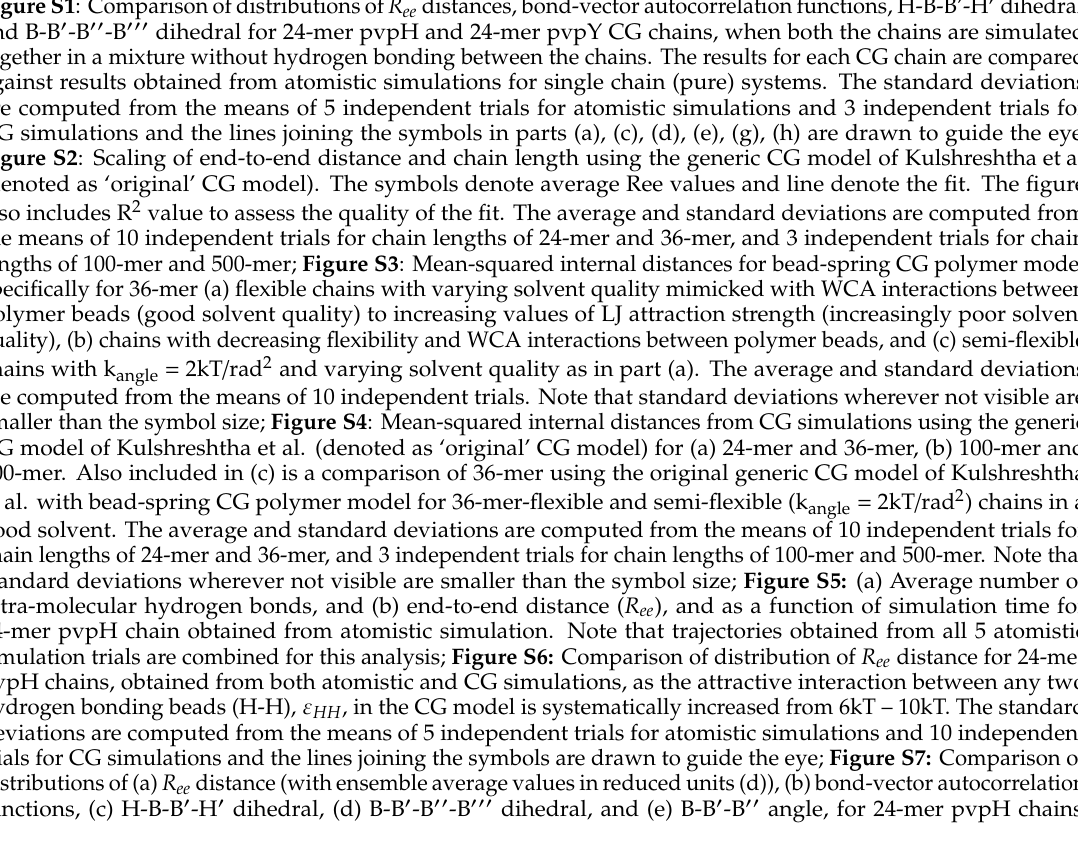
Figure S1 : Comparison of distributions of R ee distances, bond-vector autocorrelation functions, H-B-B’-H (cid:48) dihedral, and B-B (cid:48) -B (cid:48)(cid:48) -B (cid:48)(cid:48)(cid:48) dihedral for 24-mer pvpH and 24-mer pvpY CG chains, when both the chains are simulated together in a mixture without hydrogen bonding between the chains. The results for each CG chain are compared against results obtained from atomistic simulations for single chain (pure) systems. The standard deviations are computed from the means of 5 independent trials for atomistic simulations and 3 independent trials for CG simulations and the lines joining the symbols in parts (a), (c), (d), (e), (g), (h) are drawn to guide the eye; Figure S2 : Scaling of end-to-end distance and chain length using the generic CG model of Kulshreshtha et al. (denoted as ‘original’ CG model). The symbols denote average Ree values and line denote the fit. The figure also includes R 2 value to assess the quality of the fit. The average and standard deviations are computed from the means of 10 independent trials for chain lengths of 24-mer and 36-mer, and 3 independent trials for chain lengths of 100-mer and 500-mer; Figure S3 : Mean-squared internal distances for bead-spring CG polymer model specifically for 36-mer (a) flexible chains with varying solvent quality mimicked with WCA interactions between polymer beads (good solvent quality) to increasing values of LJ attraction strength (increasingly poor solvent quality), (b) chains with decreasing flexibility and WCA interactions between polymer beads, and (c) semi-flexible chains with k angle = 2kT / rad 2 and varying solvent quality as in part (a). The average and standard deviations are computed from the means of 10 independent trials. Note that standard deviations wherever not visible are smaller than the symbol size; Figure S4 : Mean-squared internal distances from CG simulations using the generic CG model of Kulshreshtha et al. (denoted as ‘original’ CG model) for (a) 24-mer and 36-mer, (b) 100-mer and 500-mer. Also included in (c) is a comparison of 36-mer using the original generic CG model of Kulshreshtha et al. with bead-spring CG polymer model for 36-mer-flexible and semi-flexible (k angle = 2kT / rad 2 ) chains in a good solvent. The average and standard deviations are computed from the means of 10 independent trials for chain lengths of 24-mer and 36-mer, and 3 independent trials for chain lengths of 100-mer and 500-mer. Note that standard deviations wherever not visible are smaller than the symbol size; Figure S5: (a) Average number of intra-molecular hydrogen bonds, and (b) end-to-end distance ( R ee ), and as a function of simulation time for 24-mer pvpH chain obtained from atomistic simulation. Note that trajectories obtained from all 5 atomistic simulation trials are combined for this analysis; Figure S6: Comparison of distribution of R ee distance for 24-mer pvpH chains, obtained from both atomistic and CG simulations, as the attractive interaction between any two hydrogen bonding beads (H-H), ε HH , in the CG model is systematically increased from 6kT – 10kT. The standard deviations are computed from the means of 5 independent trials for atomistic simulations and 10 independent trials for CG simulations and the lines joining the symbols are drawn to guide the eye; Figure S7: Comparison of distributions of (a) R ee distance (with ensemble average values in reduced units (d)), (b) bond-vector autocorrelation functions, (c) H-B-B (cid:48) -H (cid:48) dihedral, (d) B-B (cid:48) -B (cid:48)(cid:48) -B (cid:48)(cid:48)(cid:48) dihedral, and (e) B-B (cid:48) -B (cid:48)(cid:48) angle, for 24-mer pvpH